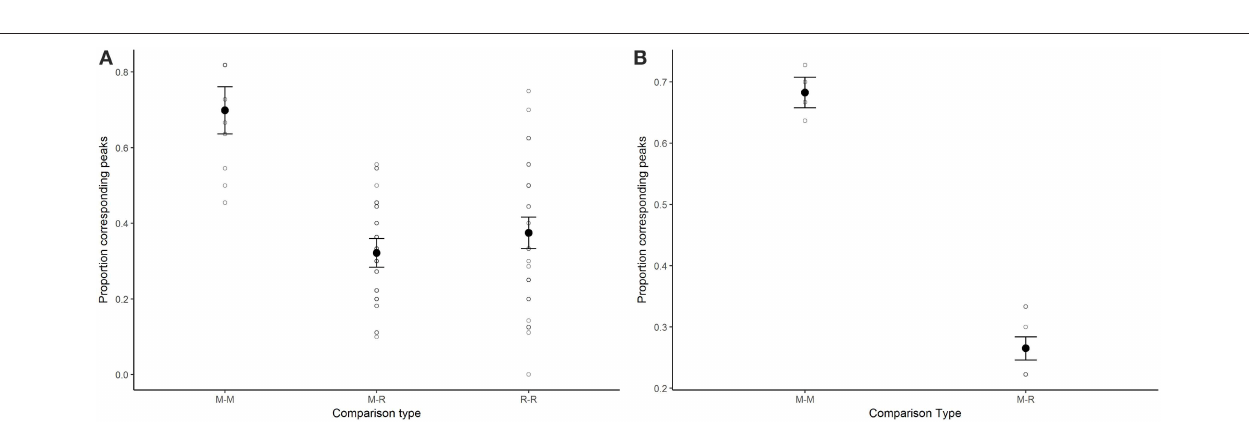
FIGURE 3 | Model derived estimates (black circles) and associated standard errors of the spearman rank correlation of species-species annual population indices for models that tested for a difference among groups (M, migrant; R, resident), for (A) a model that looked at all species-species comparisons across the 14 migrant and resident species (M-M: n = 10; M-R, n = 45; R-R, n = 36), and (B) a model that included only species-species comparisons that included the monarch butterfly (M-M, n = 4; M-R, n = 7). In both cases, the raw spearman correlation coefficient for each species-species comparison is also plotted for each group (open circles).